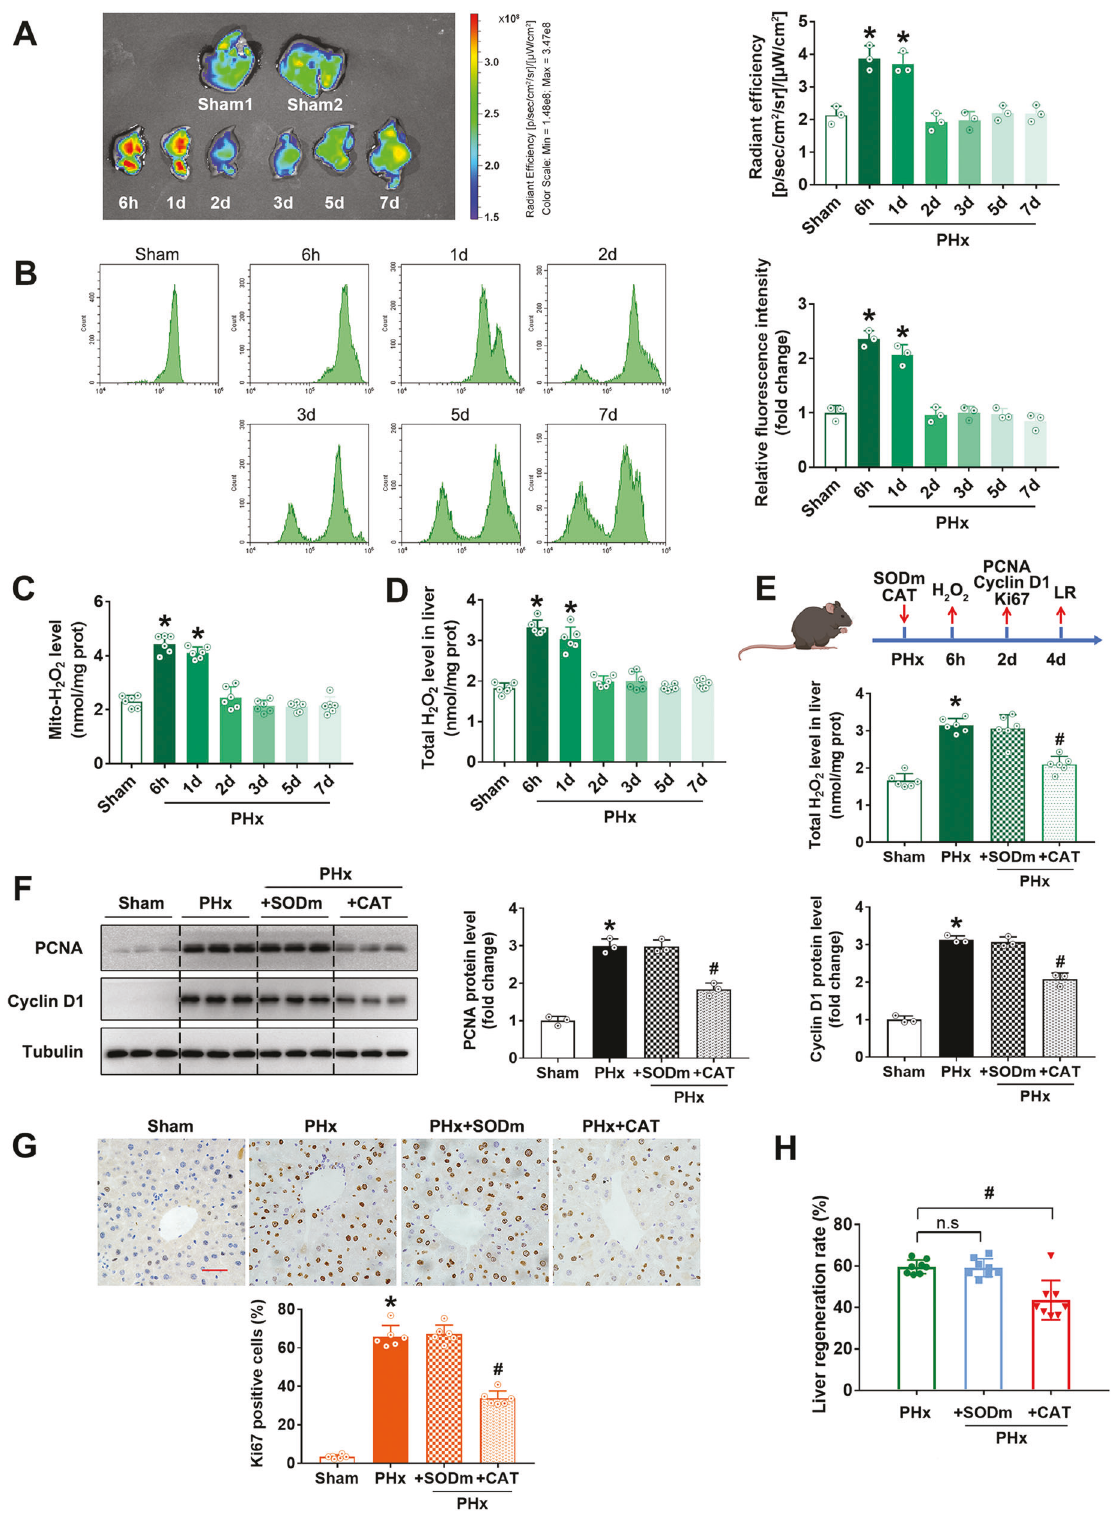
Fig. 3 Mitochondria-derived H 2 O 2 promoted LR after PHx in mice. A – D The mitochondrial H 2 O 2 and total H 2 O 2 were determined at different time points (6 h, 1 d, 2 d, 3 d, 5 d, and 7 d) after the C57 mice were subjected to PHx. A Representative liver fl uorescence images and quanti fi ed data of radiant ef fi ciency of Mito-LX probe (three independent experiments). B Flow cytometry assay and quanti fi cation of mitochondrial H 2 O 2 probed with Mito-LX (three independent experiments). C and D Mitochondrial H 2 O 2 and total H 2 O 2 in liver tissue assessed by Amplex red kit, n = 6. E – H The C57 mice were intraperitoneally injected with O 2 (cid:129) − scavenger SOD mimic (5 mg/kg BW) or H 2 O 2 scavenger CAT (10mg/kg BW) immediately after PHx and followed by once every day. The liver H 2 O 2 was detected at 6 hours and LR was determined on the 2nd day after PHx. E Schematic representation of the experimental procedure and total H 2 O 2 in liver tissue detected by Amplex red kit, n = 6. F Western blot analysis and quanti fi cation of PCNA and Cyclin D1 (three independent experiments). G Immunohistochemistry staining and quanti fi cation of Ki67, bar = 50 µm, n = 6. (H) LR rate, n = 7. Data are shown as means ± SEM. * P < 0.05 vs Sham group and # P < 0.05 vs PHx group. Cell Death and Disease (2023)